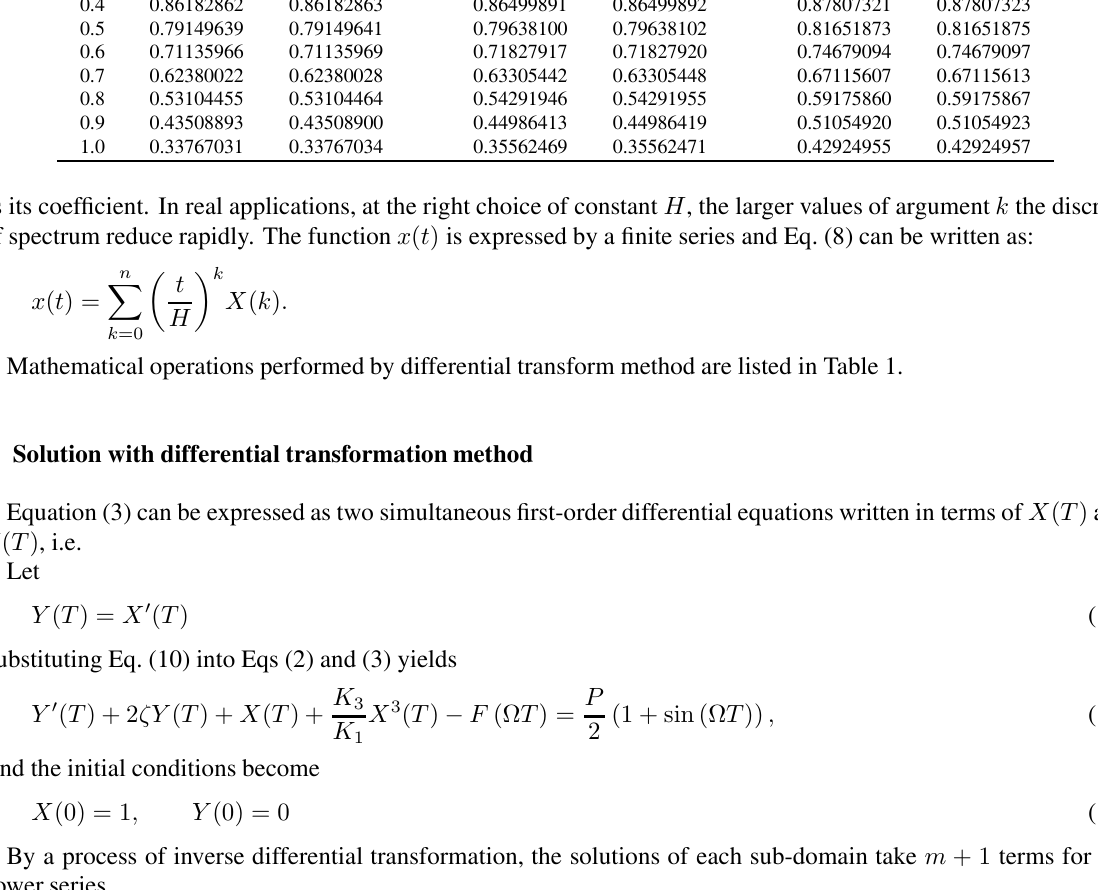
The comparison between the Numerical and DTM solution of X ( T ) for various P , when ζ = 0 . 1 , Ω = 0 . 5 and K 3 K P = 0 . 25 P = 0 .